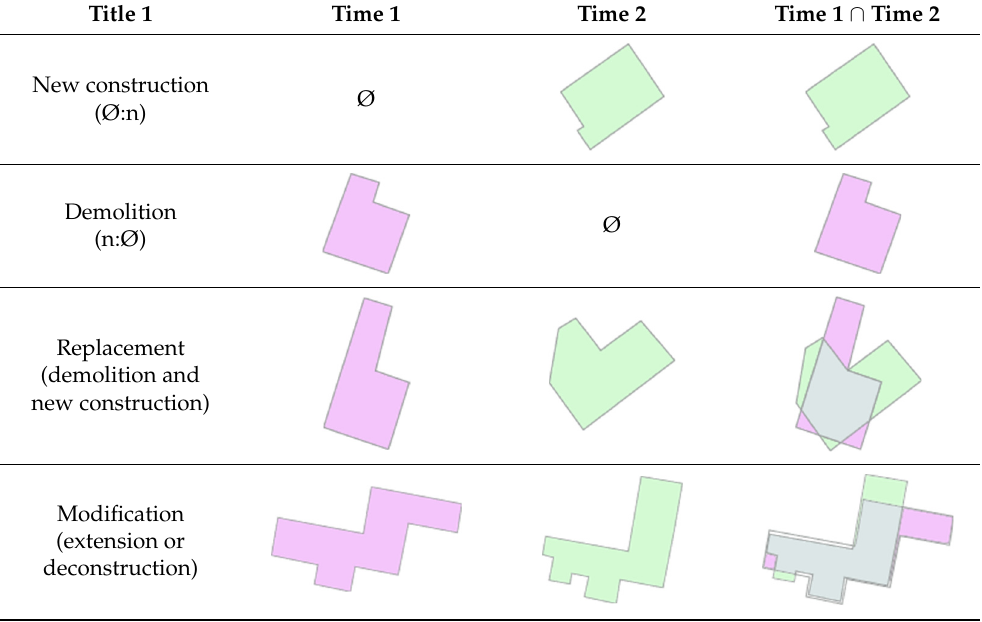
Figure 2. Study area, city of Hamburg (2015–2018); investigated intersection polygons of noniden- tical object-pairs (n = 2285) highlighted in pink on the left side.